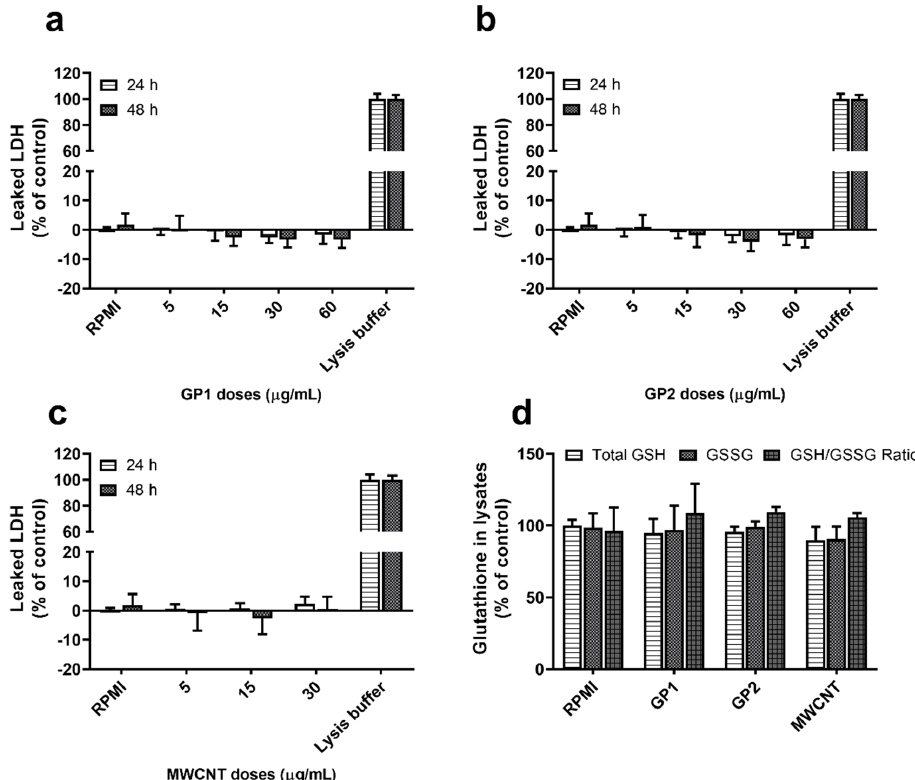
Figure 2. Monocytes’ response to C-BNMs; Viability of monocytes assessed as %-leakage of LDH after 24 and 48 h expo- sure to ( a ) GP1, ( b ) GP2 and ( c ) MWCNTs. Data are reported as mean ± standard deviation (Leaked LDH % = (T-RPMI)/(L- RPMI) × 100). T —test cells, RPMI —untreated control, L —Lysates. ( d ) Glutathione content in monocyte lysates after 24 h exposure to GPs (60 μ g/mL) and MWCNTs (30 μ g/mL). Data are presented as % of untreated control (RPMI) and expressed